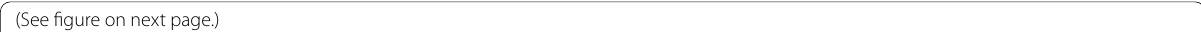
75μm. K Quantification of = =